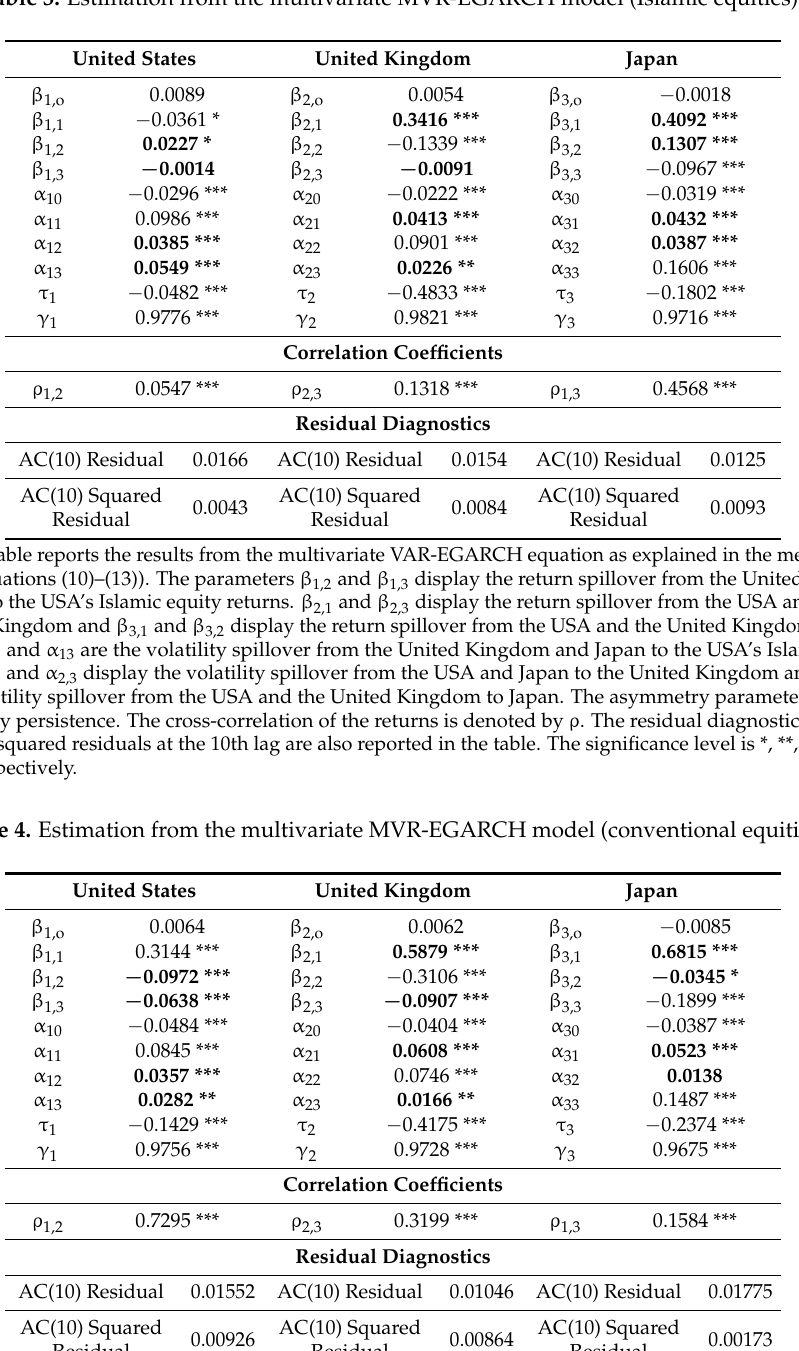
Table 3. Estimation from the multivariate MVR-EGARCH model (Islamic equities).